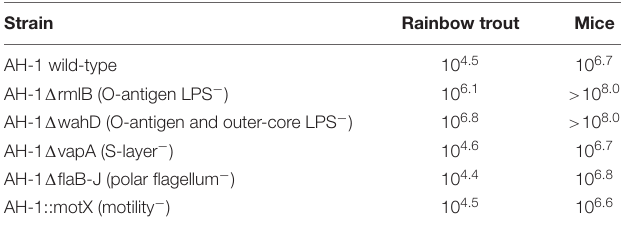
TABLE 2 | LD 50 for rainbow trout and mice of Aeromonas hydrophila AH-1 and its mutants upon intraperitoneal injection of strains grown in TSB at 20 ◦ C to infect fish and at 37 ◦ C to infect